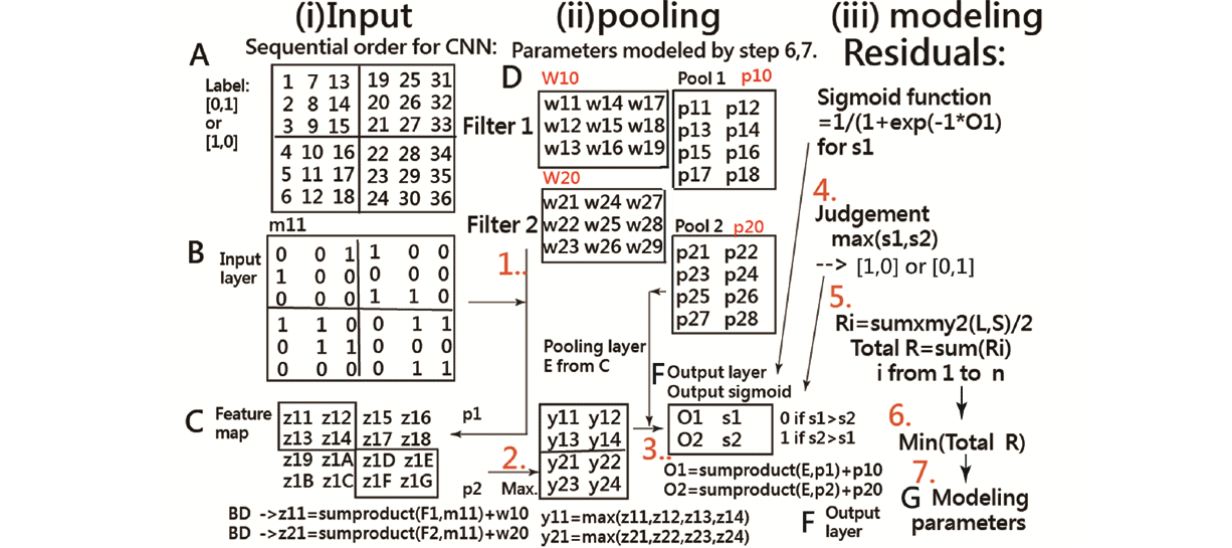
Figure 1. Interpretation of the convolutional neural network algorithm in Microsoft Excel. CNN: convolutional neural